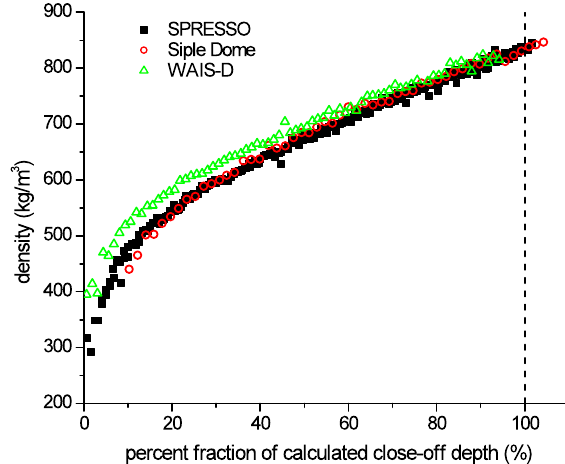
Fig. 4. Ice density for SPRESSO (black squares), Siple Dome (red Figure 4. Ice density for SPRESSO (black squares), Siple Dome (red circles), and circles), and WAIS-D (green triangles) cores. The x-axis is a nor- WAIS-D (green triangles) cores. The x-axis is a normalized depth scale calculated by malized depth scale calculated by dividing the depth of density mea- dividing the depth of density measurements by the firn close-off depth calculated from surements by the firn close-off depth calculated from Eq. (1) (sur- face at 0%). The dashed line indicates full close-off as predicted by equation (1) (surface at 0%). The dashed line indicates full close-off as predicted by this this equation. The density data extend to the actual depth, at which equation. The density data extend to the actual depth, at which the deepest firn sample at the deepest firn sample at each individual site was each individual site was collected.